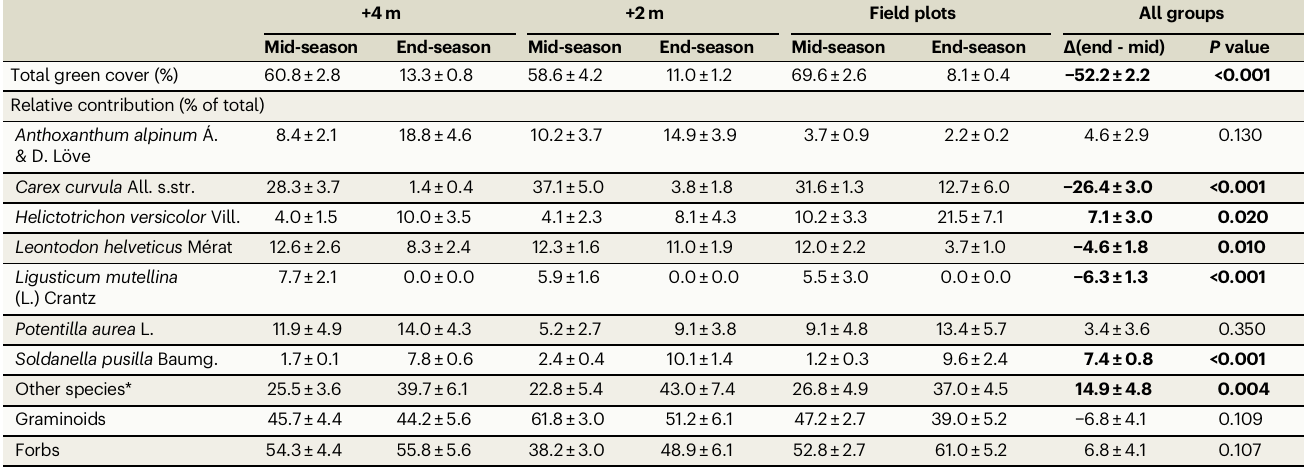
Table 2 | Total green cover mid-season and at the end of the season and the contribution of the most abundant species (mean ± SE)